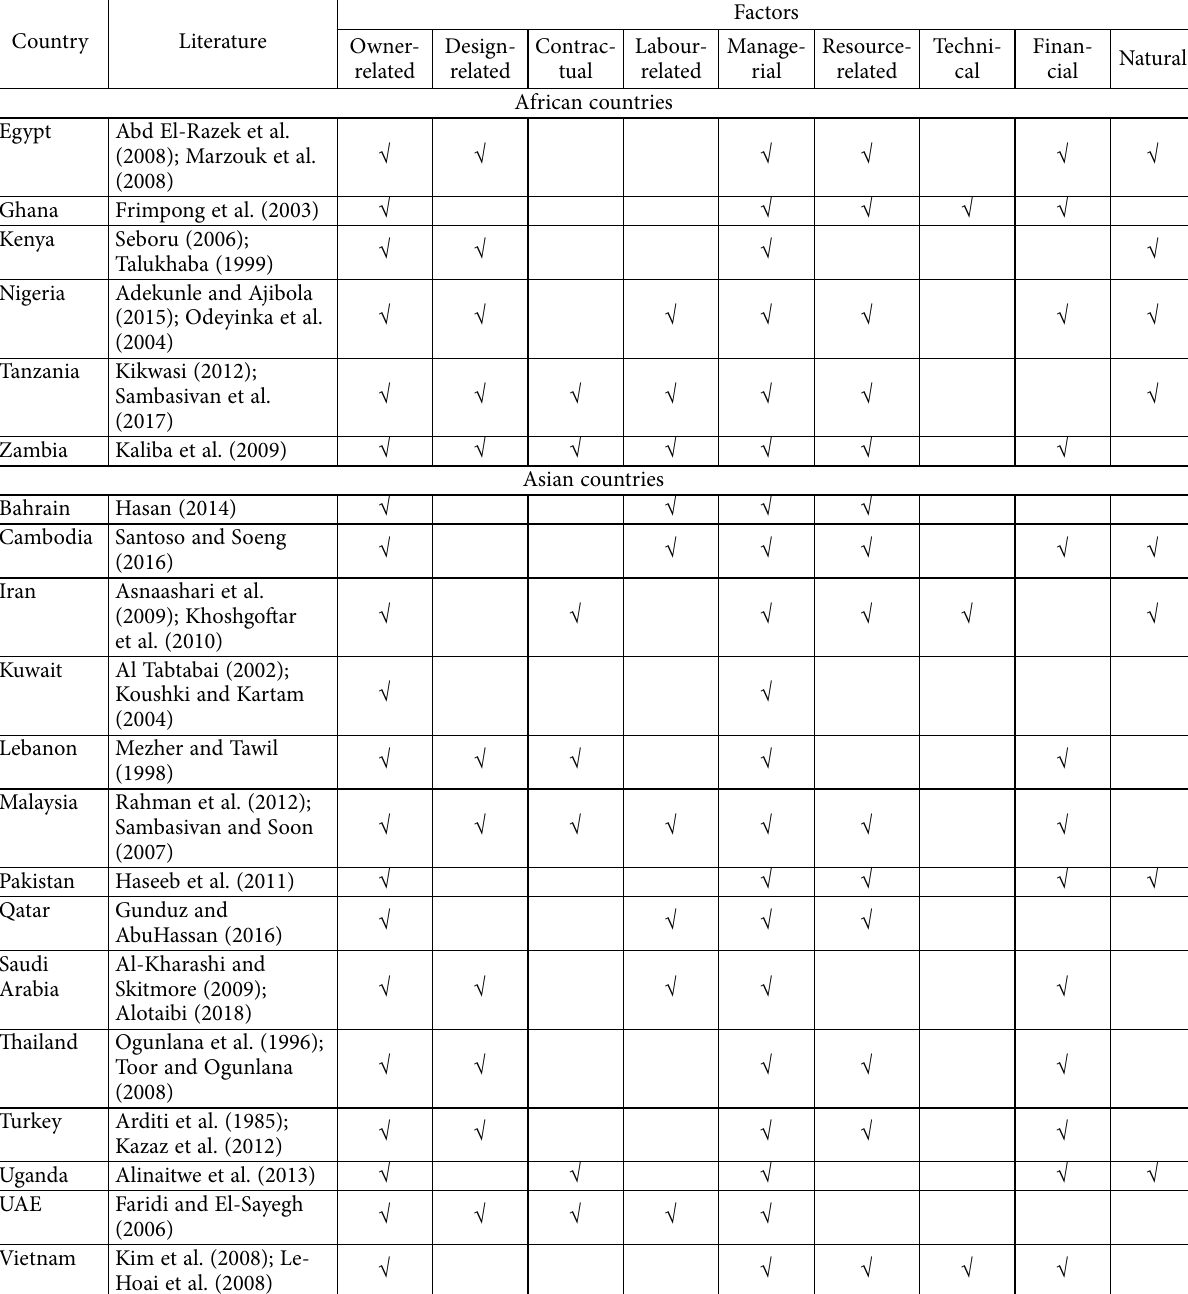
Table 1. The main causes of time overrun in developing